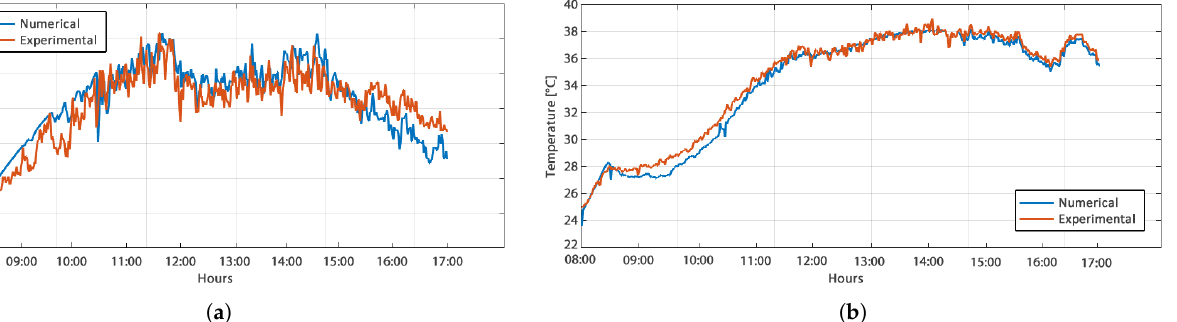
Figure 9. Temperature changes obtained by numerical and experimental studies on PV ( a ) and PV/T ( b ) modules.